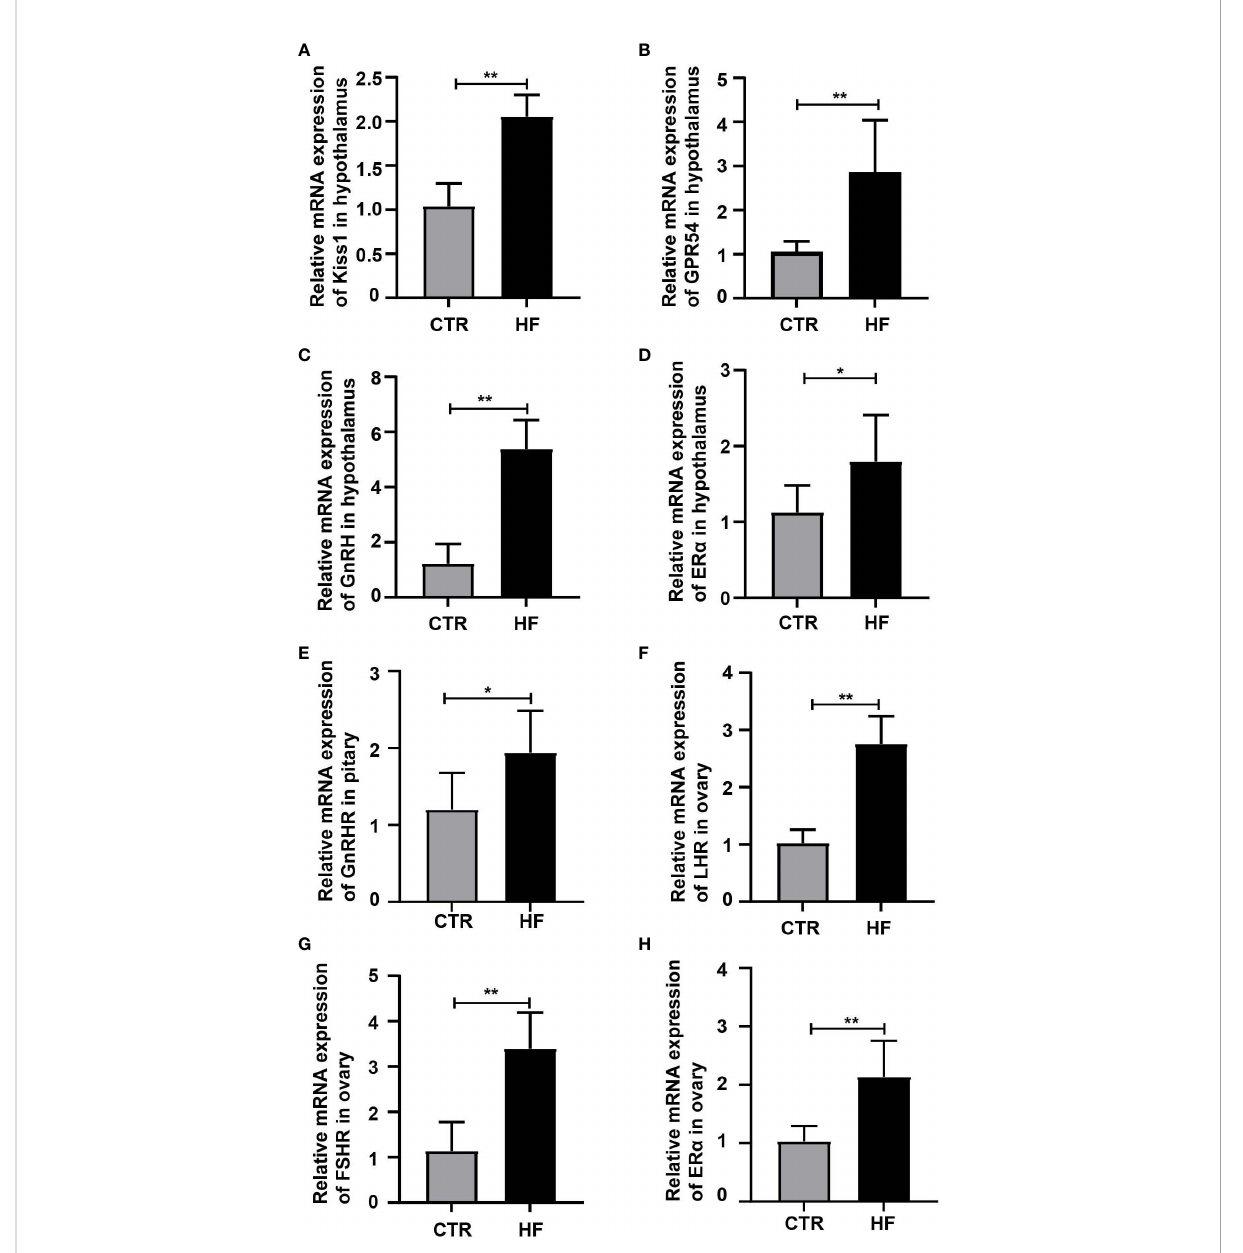
FIGURE 2 HFD promotes the gene expression of the HPGA in rats with obesity-induced precocious puberty. (A) The gene expression of Kiss1 in the hypothalamus. (B) The gene expression of GPR54 in the hypothalamus. (C) The gene expression of GnRH in the hypothalamus. (D) The gene expression of ER a in the hypothalamus. (E) The gene expression of GnRHR in the pituitary. (F) The gene expression of LHR in the ovary. (G) The gene expression of FSR in the ovary. (H) The gene expression of ER a in the ovary. n = 6 per group for rat samples. *P<0.05;